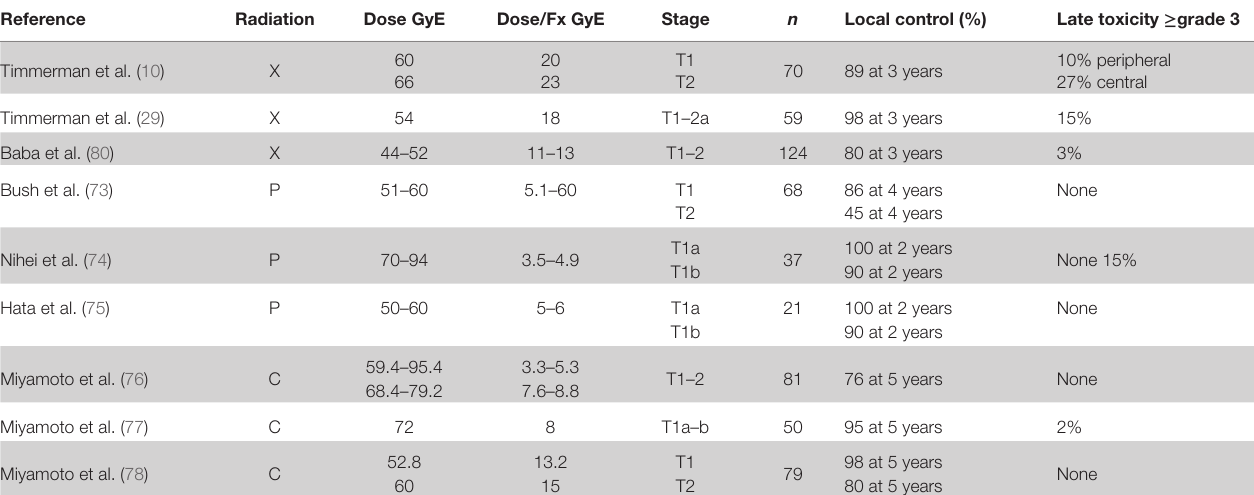
TABLe 2 | Non-small cell lung